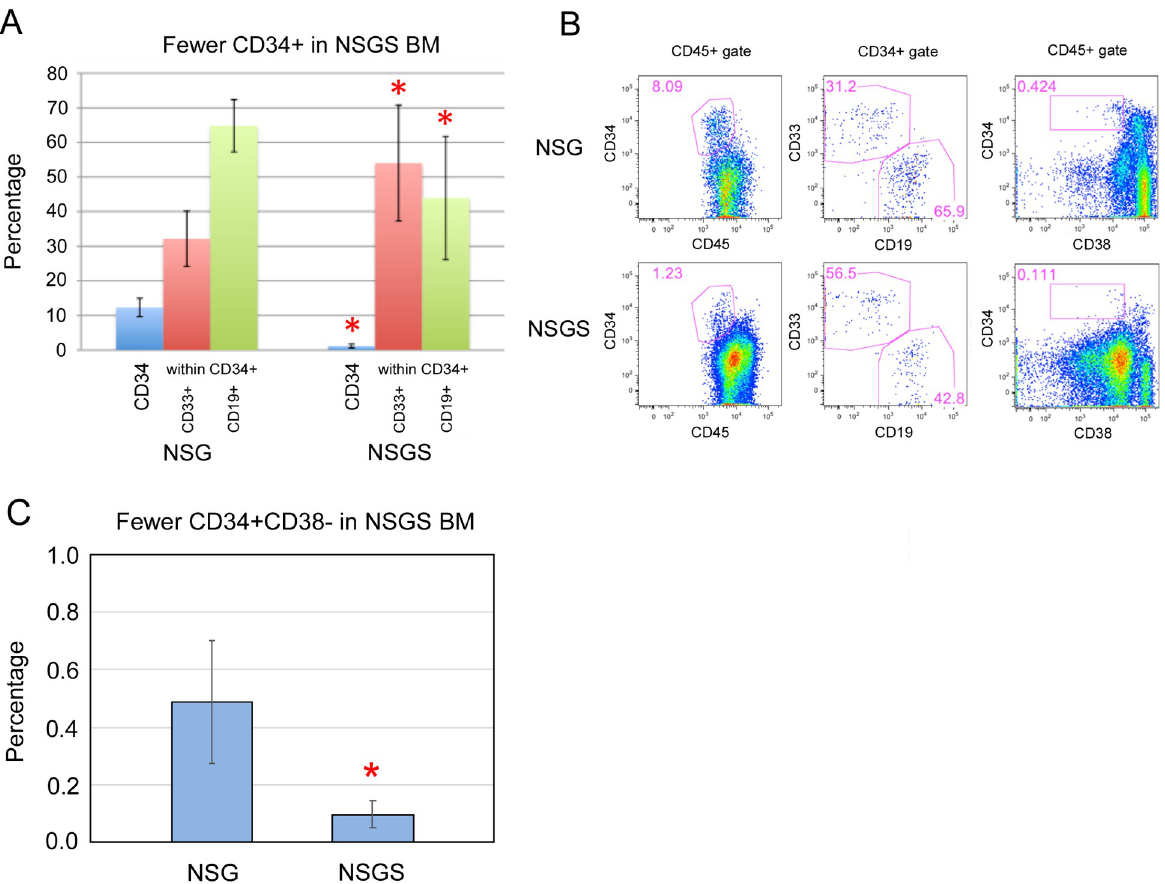
Fig 4. Reduced CD34+ cells in BM are myeloid skewed. A) Averages and B) representative FACS analysis of UCB-engrafted BM demonstrating higher CD33+ and lower CD19+ co-staining on CD34+ cells from NSGS mice engrafted for 15 weeks. C) Primitive CD34+CD38- cells were also significantly reduced in NSGS BM (flow example also shown in B). Asterisks indicate p value less than 0.05 by Student’s T Test.